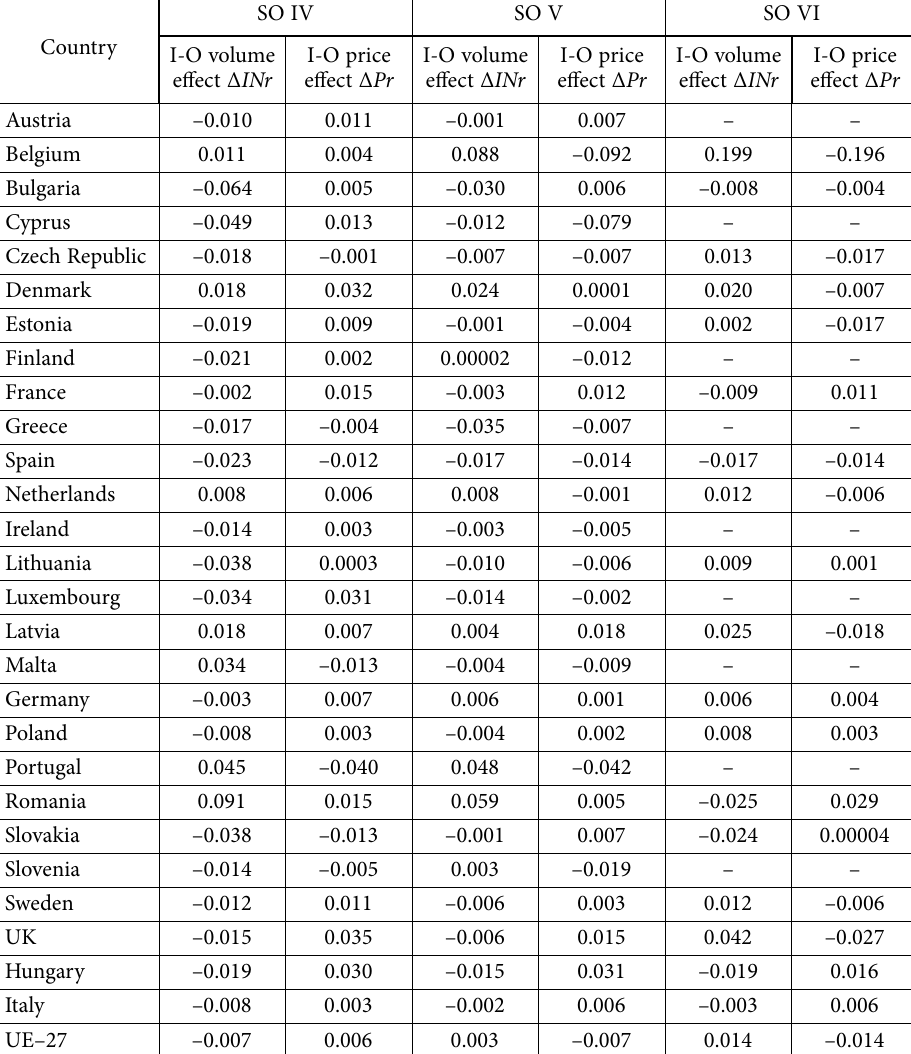
Table 3. Descriptive statistics: decomposition of price and volume effect in € related to output; year averages in 2004–2012 in the range of different economic size of farms (SO IV - SO VI) (source: own calculations using EU FADN data and EAA Eurostat prices)